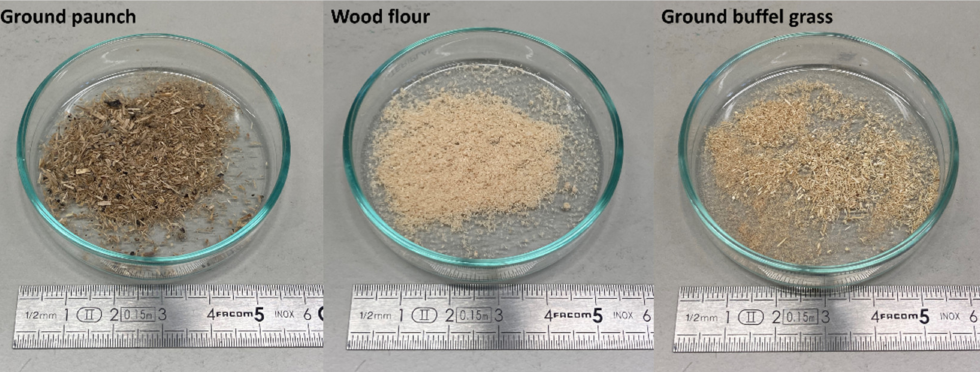
Figure 1. Appearance of ground paunch ( left ), wood flour ( middle ) and ground buffel grass ( right ) after